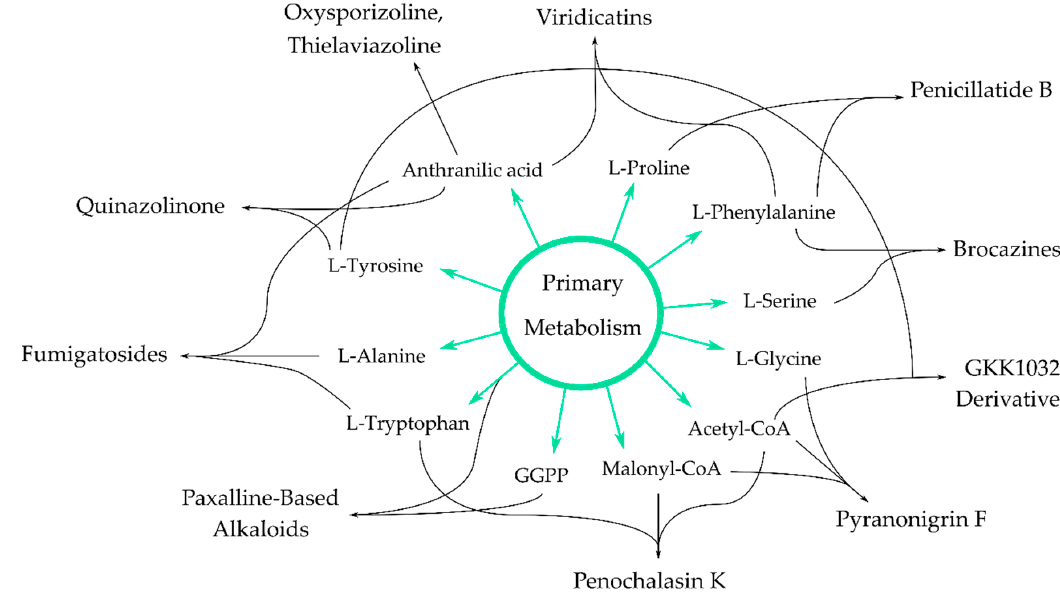
Figure 9. Schematic representation of the proposed biochemical origin of the antimicrobial alkaloids discussed in this review, discovered from 2015 until today.